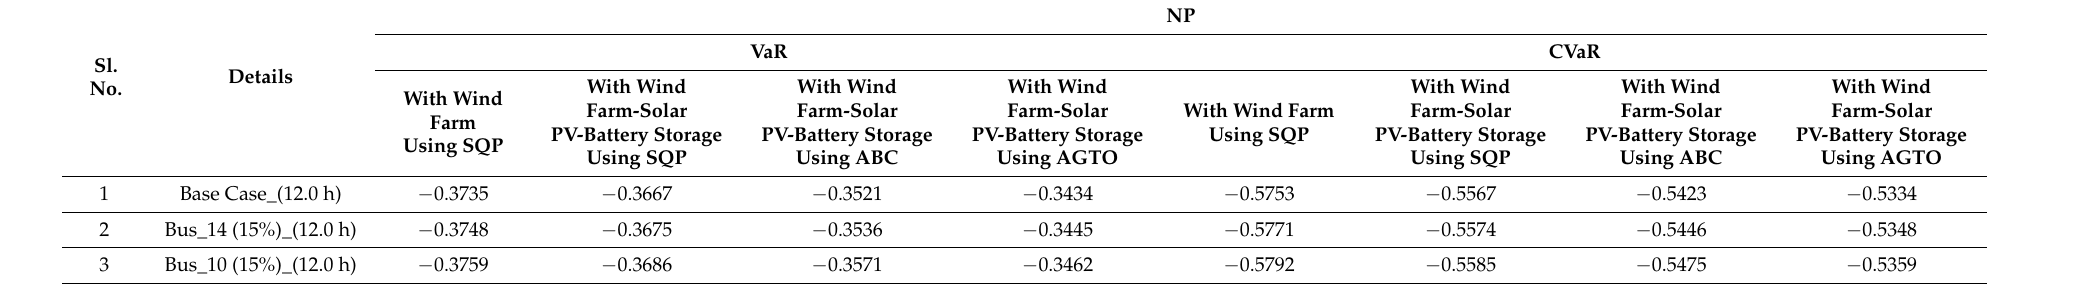
Table 10. System risk with different optimization techniques (for